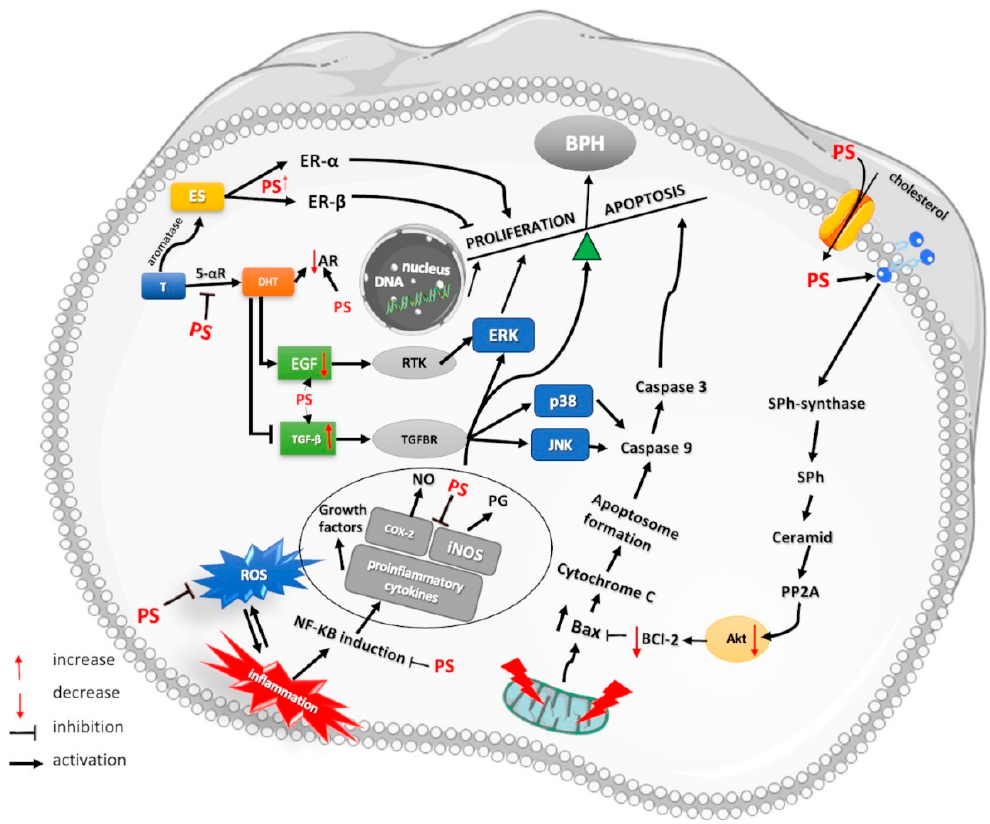
Figure 3. Schematic representation of mechanism involved in BPH. Anti-androgenic, anti-inflammatory, antioxidant, and pro-apoptotic mechanisms of PSs. PS: phytosterols, ES: estrogen, T: testosterone, DHT: dihydrotestosterone, Bcl-2: B-cell lymphoma 2, Bax: Bcl-2- associated X protein, ERK: extracellular signal-regulated protein kinase, JNK: Jun N-terminal Kinase, EGF: epidermal growth factor, TGF- β : transforming growth factor β , PP2A: phosphatase A, 5- α R: 5 α -reductase, COX-2: cyclooxygenase-2, iNOS: inducible nitric oxide synthase, RTK: receptor tyrosine kinase, TGFBR: TGF- β receptor, ROS: reactive oxygen species; PG: prostaglandins; Akt: protein kinase B; SPh: sphingomyelin; Sph-synthase: sphingomyelin synthase.